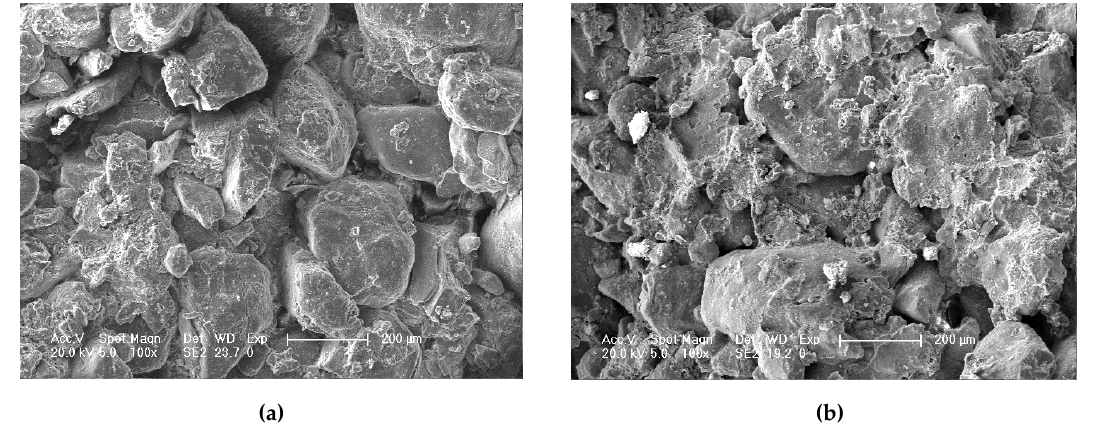
Figure 1. Magnification 100× microscopic images (a) S0 and (b) S2.